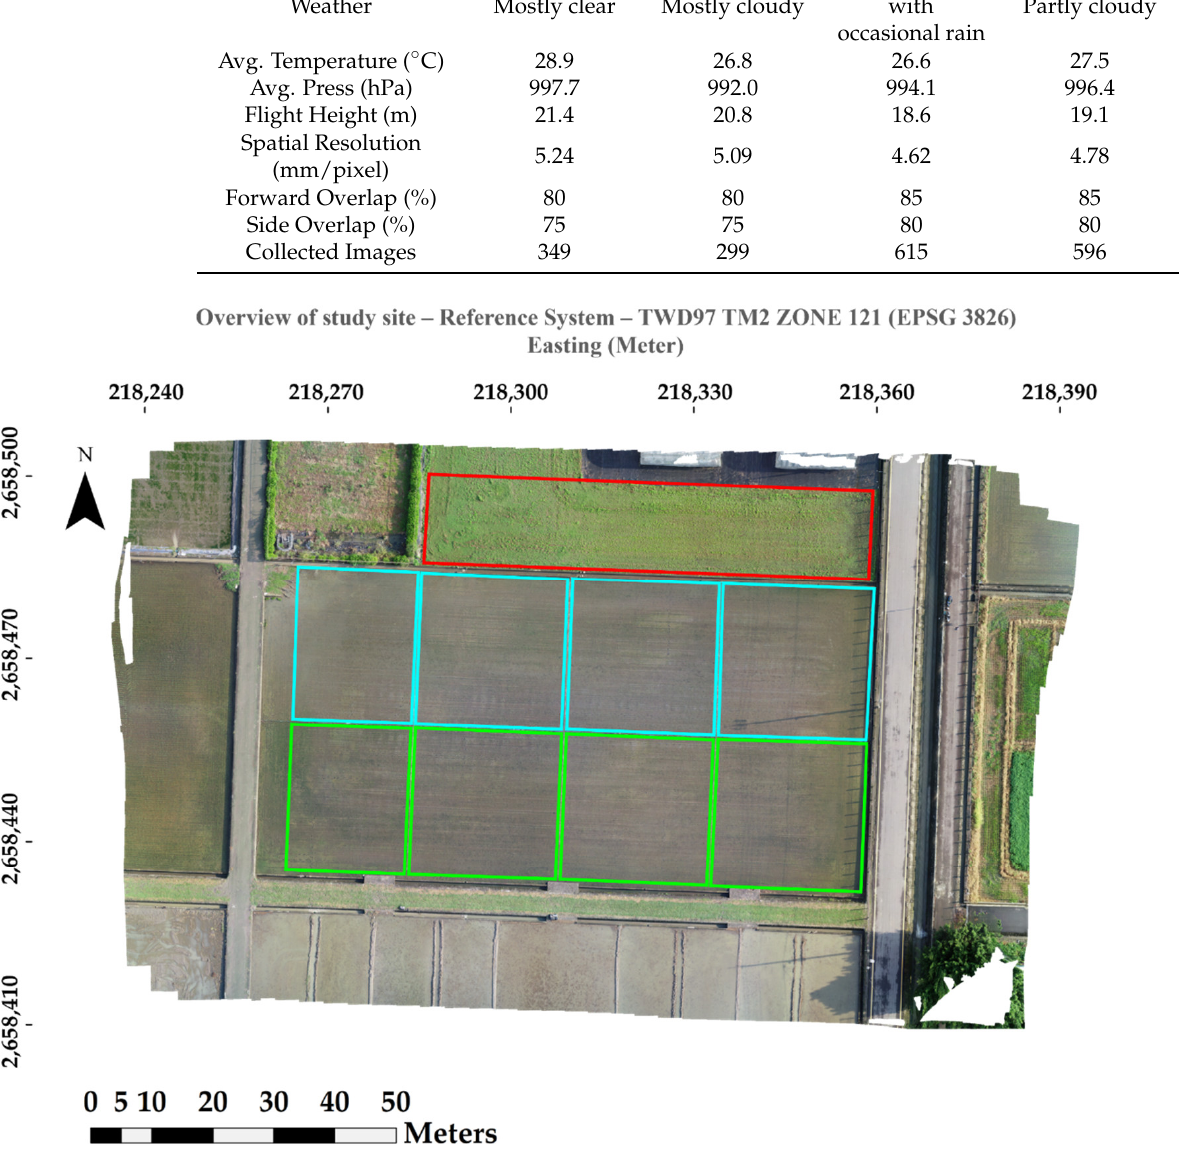
Figure 3. Sample images of rice seedlings in a paddy field image dataset [61]. Table 1. UAV imaging sensor details [61].